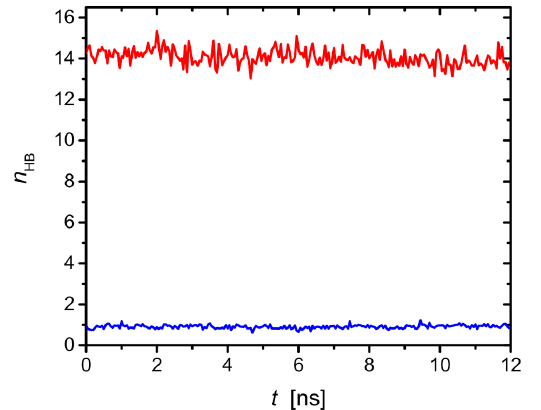
Figure 4. Average number of hydrogen bonds formed by one GOTCAB molecule as a function of time. The results are averaged over three independent simulations performed for GOTCAB/H 2 O systems. The red curve corresponds to HB formed by the GOTCAB and water molecules, while the blue curve corresponds to intra- or inter-GOTCAB